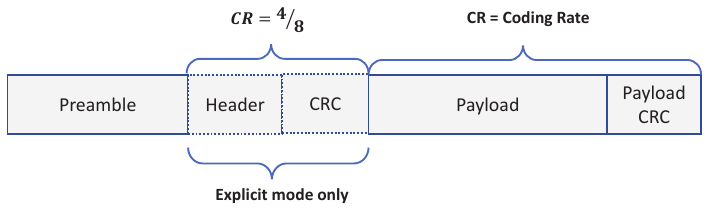
Figure 2. LoRa Frame